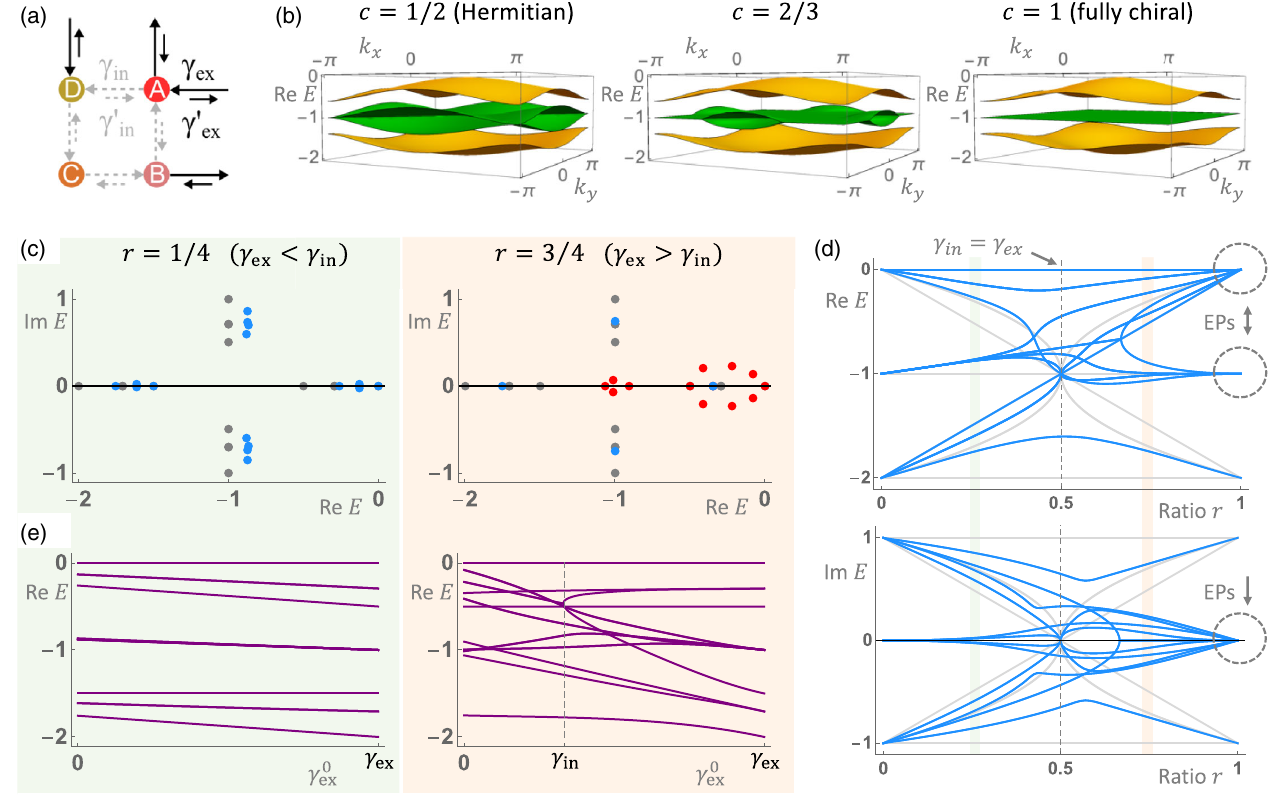
FIG. 4. Berry connection and exceptional points. (a) Allowing for the reverse transitions γ 0 and γ 0 , we generalize the phase space of ex in our system to be determined by the ratio r weighting external to internal transitions and the chirality c , which tunes the system from Hermitian to non-Hermitian. (b) The real spectra of W for the square lattice with periodic boundary conditions (PBC) are plotted in reciprocal space ð k x ; k y Þ for increasing values of c , at r ¼ 0 . 7 . The top E and bottom E − ; bands are in yellow, and the middle bands þ ; þ þ E and E − ; − are in green. The system remains in the topological phase as c increases from 1 = 2 in the Hermitian case to 1 in the fully þ ; − chiral limit since the band gap remains open. (c) The complex spectra are plotted in the trivial phase ( r ¼ 1 = 4 , green background) and in the Zak phase ( r ¼ 3 = 4 , cream background), where gray denotes PBC and blue denotes open boundary conditions (OBC). Edge states (red points) are seen under OBC in the Zak phase, as expected from the bulk-boundary correspondence. (d) As r → 1 in the topological phase, the edge states coalesce towards E ¼ 0 and E ¼ − γ , such that many edge states become close to the ground state in the former. tot These points of coalescence are exceptional points (EPs, indicated by dashed circles), unique non-Hermitian features at which the system becomes singular, and are present in OBC (blue) but absent in PBC (gray). (e) Real spectra as a function of the edge link γ 0 that ex γ 0 ), where EPs emerge in the Zak phase ( r ¼ 3 = 4 , cream background) at ) and OBC ( γ 0 interpolates between PBC ( γ 0 ex ¼ ex ¼ ex γ γ 0 . In contrast, EPs are absent in the trivial phase ( r ¼ 3 = 4 , green background). Parameters used in (c) – (e): c ¼ 1 and system size in ex ¼ N N 1 . In all panels, values of E are given in units of γ x ¼ y ¼ tot